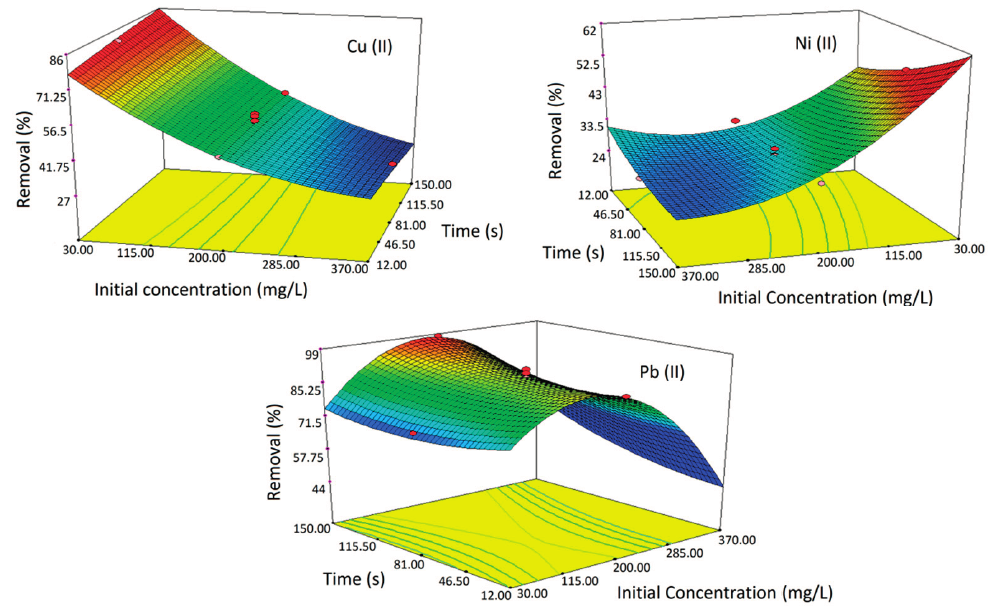
metal ion concentration and removal time for Cu(II), Ni(II) and Pb(II).